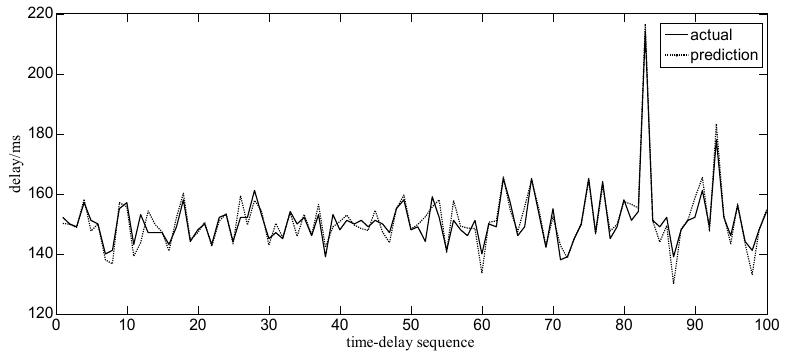
Figure 8. GA-optimized least squares (LS-SVM) time-delay prediction result.